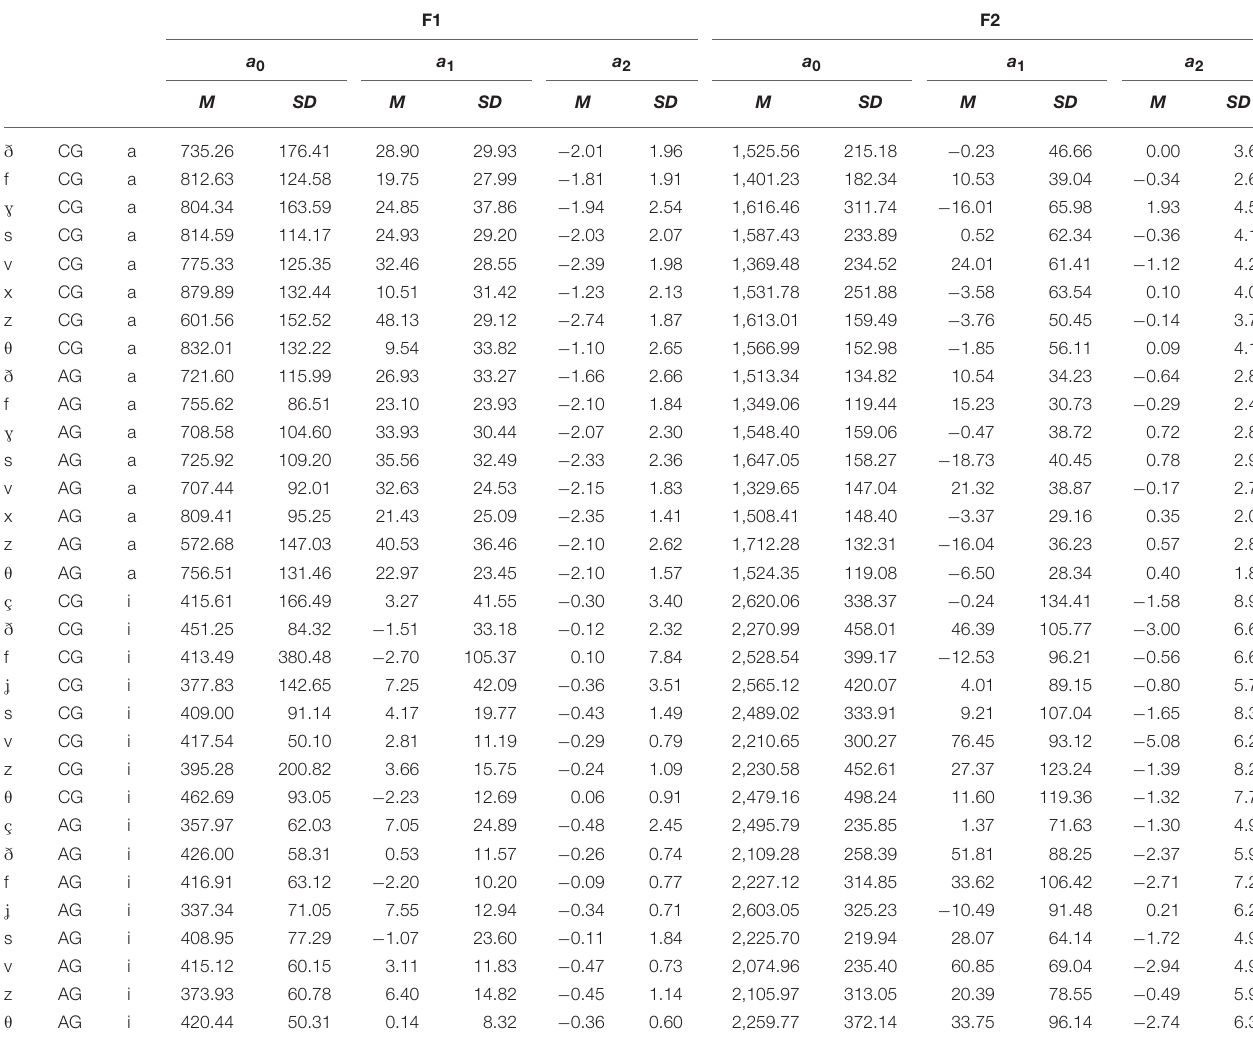
TABLE 6 | Mean and SD of a 0 , a 1 , a 2 polynomial coefficients of the formant frequencies F 1 and F 2 of vowels /a/ and /i/ as a function of fricative consonant and dialect [Athenian Greek (AG) and Cypriot Greek